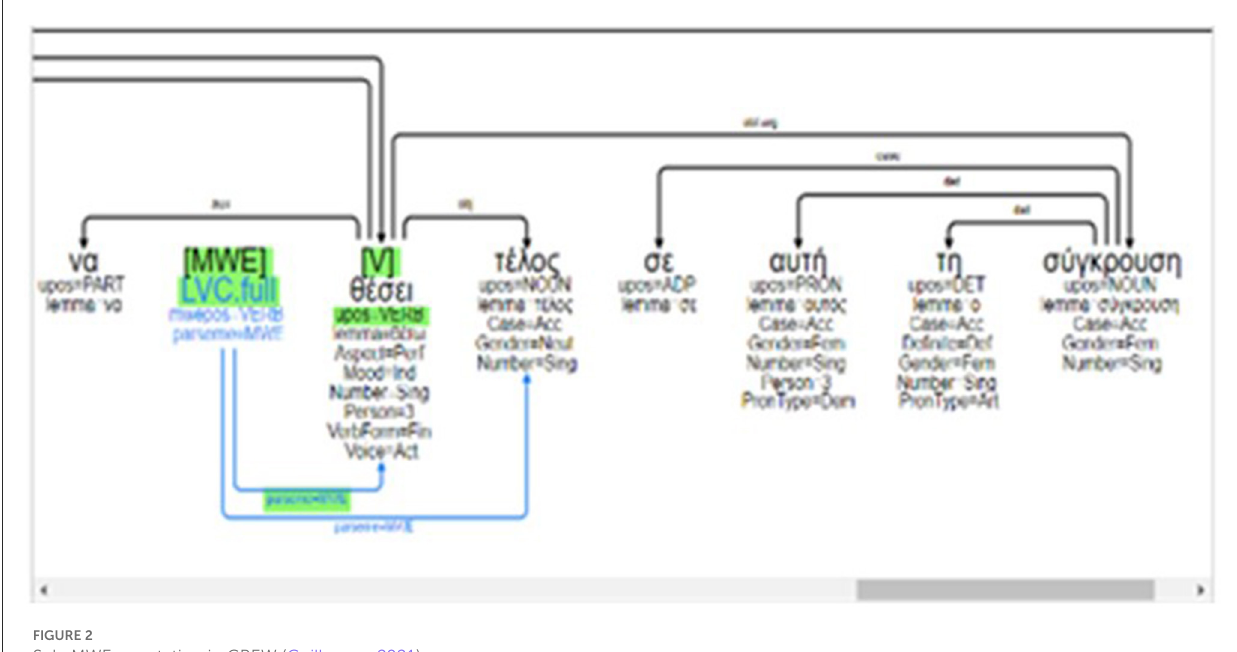
FIGURE2 Sub-MWE annotation in GREW (Guillaume, 2021).